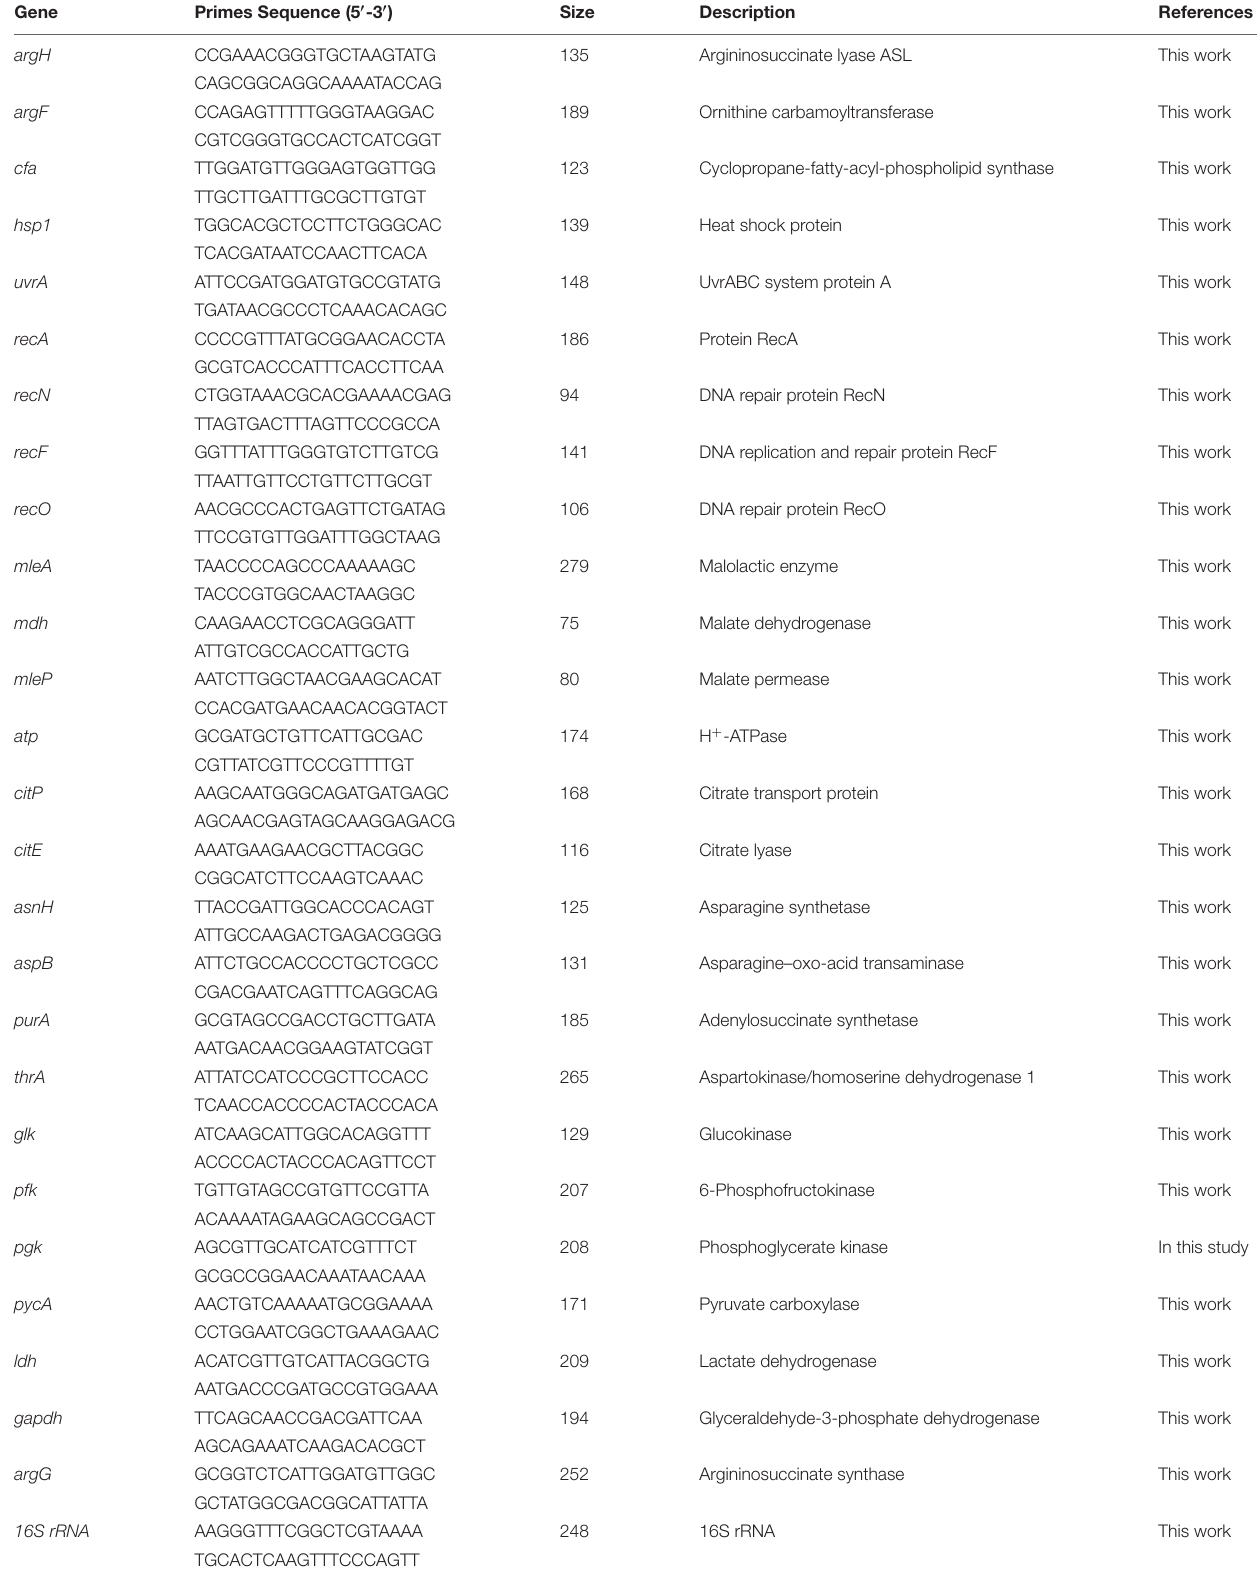
TABLE 2 | Primers used for RT-qPCR. Gene Primes Sequence (5 (cid:48) -3 (cid:48) )